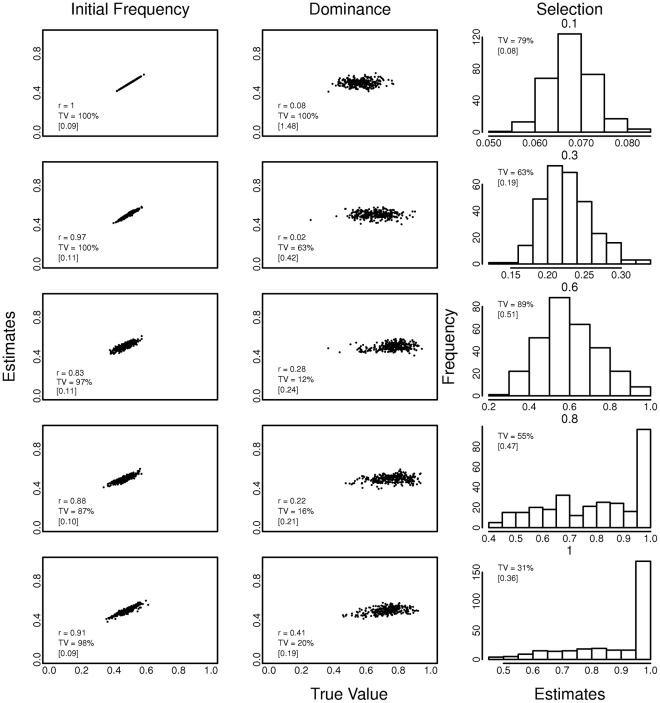
Effect of spatial heterogeneity (pooled data from 80 simulated locations) on estimates of initial allele frequency, dominance and selection parameters.The value of the selection coefficient was held constant at 0.1, 0.3, 0.6, 0.8 or 1 in all locations and in every generation, hence there are five rows of results corresponding to each of the 5 values of the selection coefficient. Dominance (h∼∪(0,1)) varied between simulated locations, but was constant over time within each location. The true value is the mean parameter value over all locations. The Pearson correlation coefficient (r) is between estimated and true values. TV is the percentage of the true values that are included in the 95% confidence interval of the estimate. [ ] is the mean width of the 95% confidence interval in all runs.